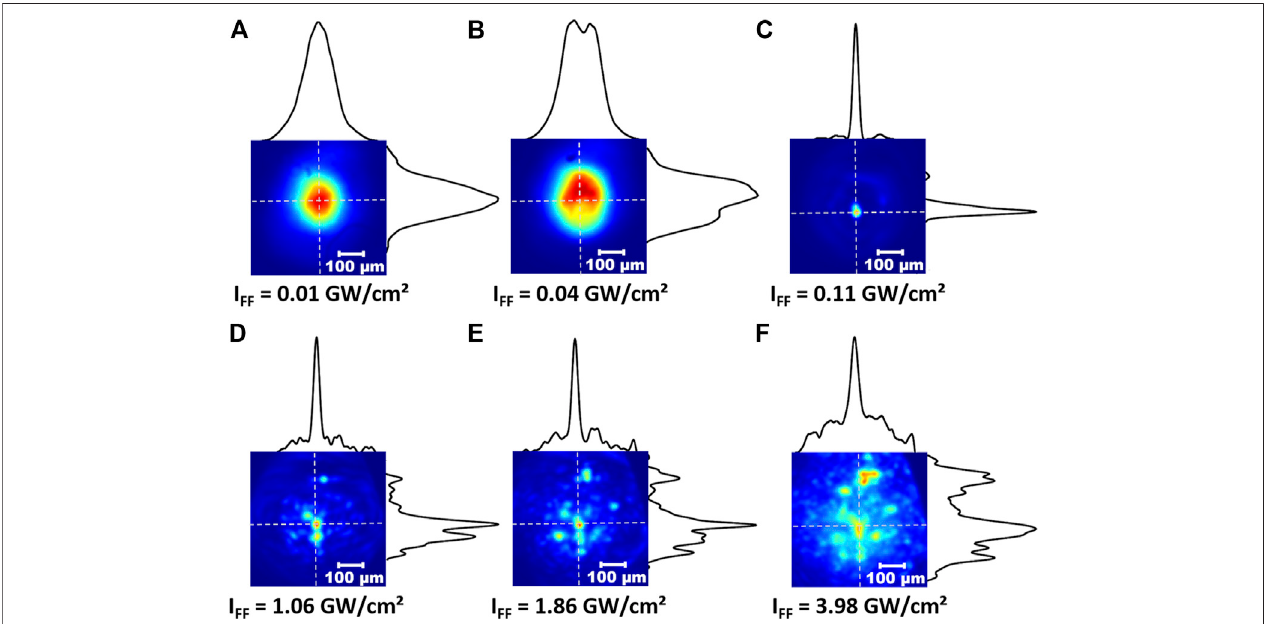
FIGURE 2 | Near- fi eld images of the SH beam at the output face of the KTP crystal. The SH beam shape is nearly Gaussian for an input intensity of 0.01 GW/cm 2 (A) . The beam is depleted near the center of the Gaussian at 0.04 GW/cm 2 of input intensity (B) then, for a pump intensity of 0.11 GW/cm 2 (C) , strong spatial compression of the SH beam is observed. Whereas for pump intensities above 1 GW/cm 2 (D) – (F) the output SH beam breaks in an irregular pattern of localized spots. These results refer to crystal orientations of θ (cid:1) 90 ° , Φ (cid:1) 23.5 ° + 0.33 ° (focusing case) and input SOP orientation of 47 ° . Colormaps are normalized to the local maximum intensity